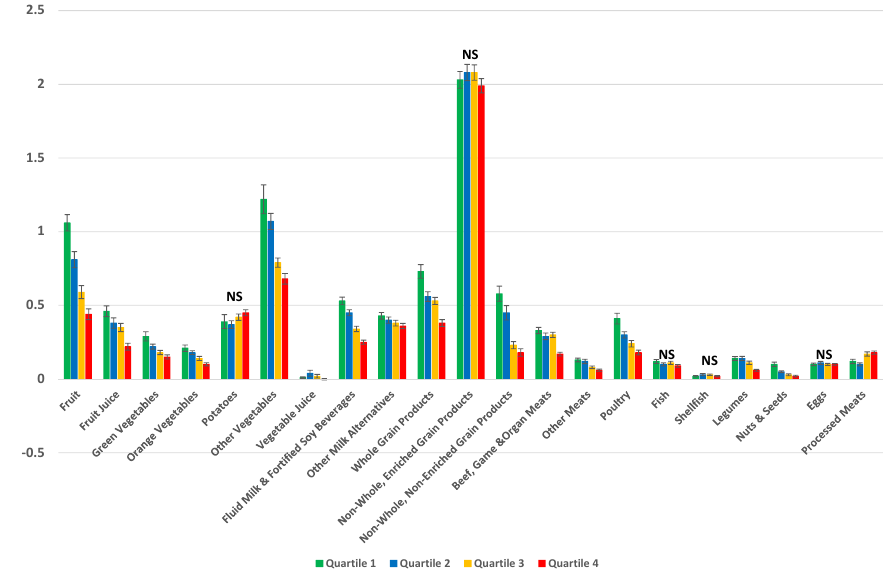
Figure 3. Implementation of 2014 Health Canada Surveillance Tool Tier system to the dietary intakes of Canadian adults ( ě 19 years) in a weighted analysis to assess the number of serving from each of the Eating Well with Canada’s Food Guide subgroups per 1000 kcal [25]. Dietary profiles of compliers (Quartile 1) *, intermediates (Quartiles 2 and 3) † , and non-compliers (Quartile 4) ‡ are compared §,|| NS, Not significant; * The 25% of individuals with the lowest percentage of energy from Tier 4 and “other” foods and beverages; † The individuals in the interquartile range for energy intakes from Tier 4 and “other” foods and beverages; ‡ The 25% of individuals with the highest percentage of energy from Tier 4 and “other” foods and beverages; § Adjusted for age, sex, and misreporting status (under-reporters, plausible-, and over-reporters); || Quartiles are based upon percentage of energy from all Tier 4 foods based on 2014 Health Canada’s Surveillance Tool Tier system plus “other” foods and beverages not recommended in the Eating Well with Canada’s Food